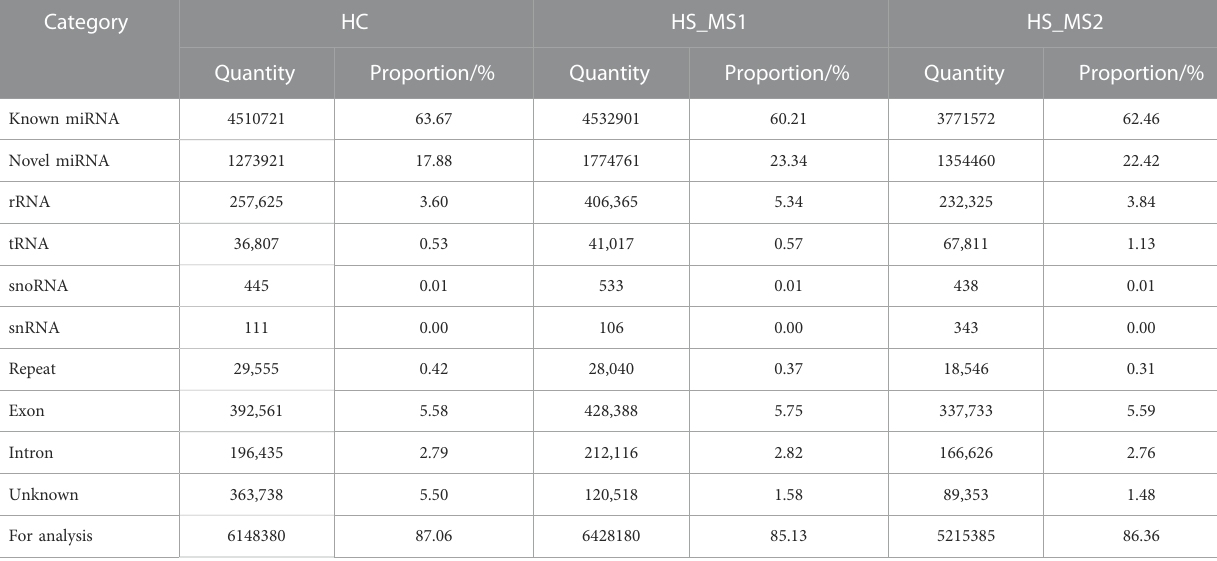
TABLE 3 Small RNA annotations and quantity distribution in the three groups (n = 6). Category